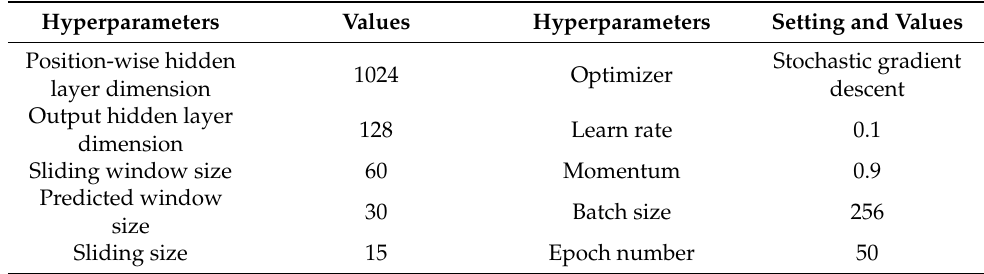
Table 2. The structural and training hyperparameters of the model.